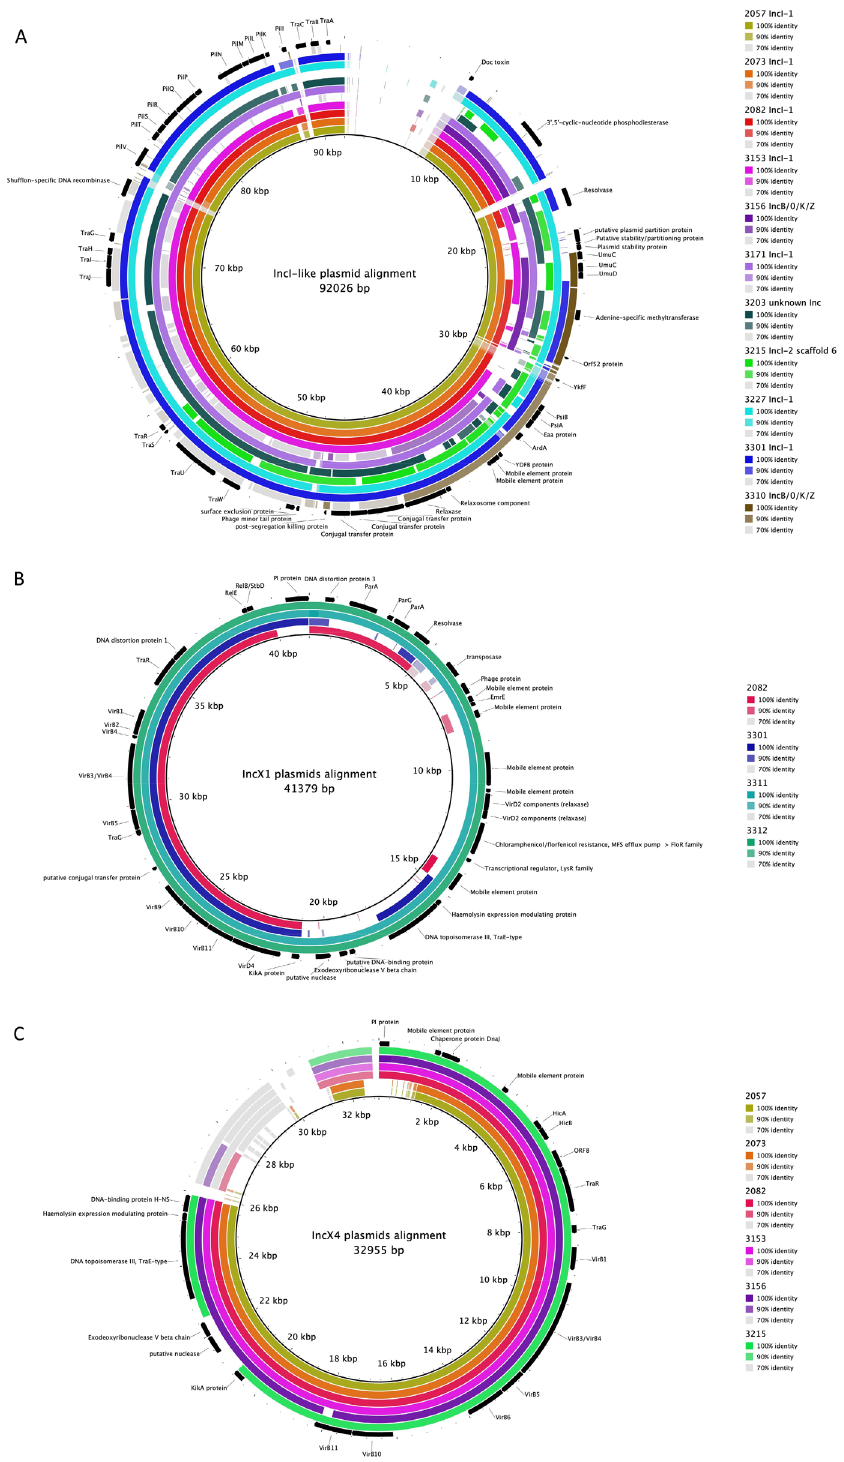
Figure 5. Alignment of IncI plasmids ( A ), IncX1 plasmids ( B ) and IncX4 plasmids ( C ) showing the alignment of all similar plasmids among all E. coli strains tested in this dataset against the annotated consensus sequence. Colors indicate the homology, where full color show 100% identity, slightly lighter color indicates 90% identity or higher, grey indicates 70% identity or higher and no color indicates less than 70%